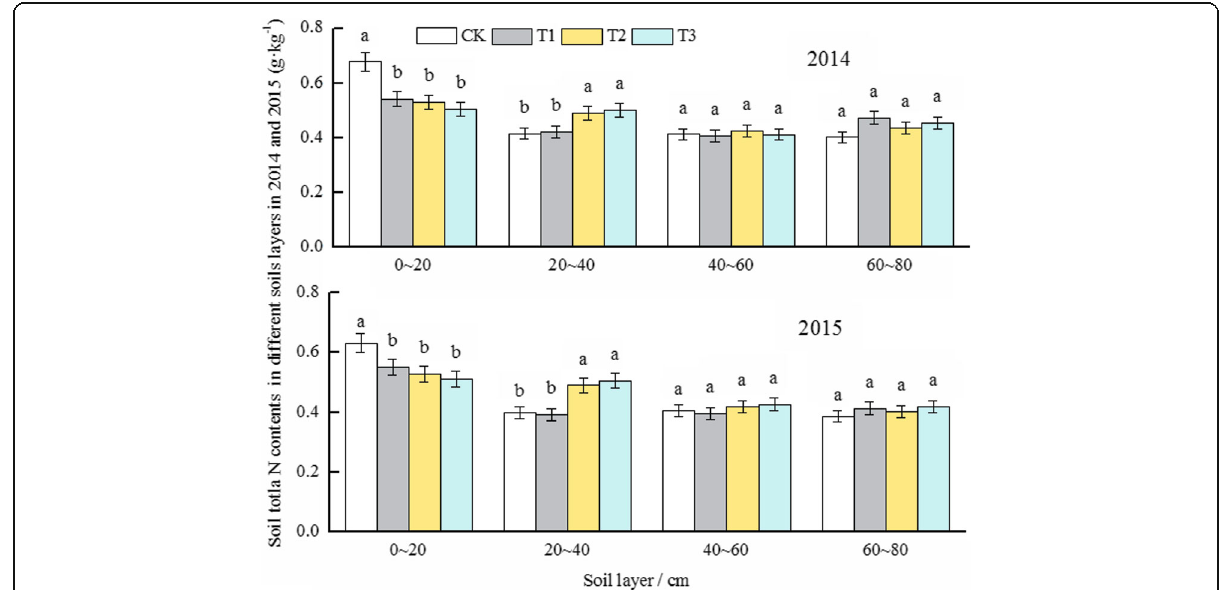
Fig. 5 Changes in total soil N contents in different soil layers in different treatments in 2014 and